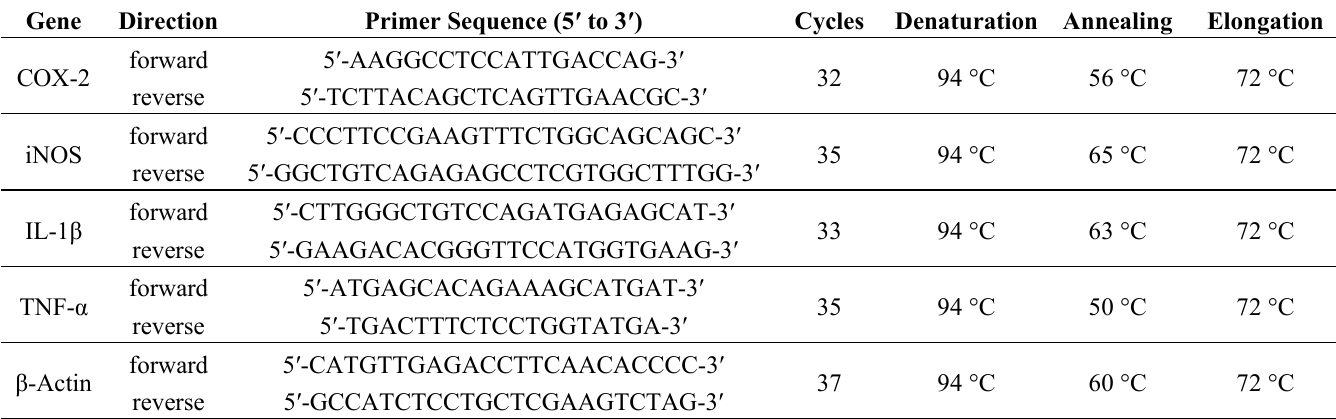
Table 1. Primer sequences and PCR